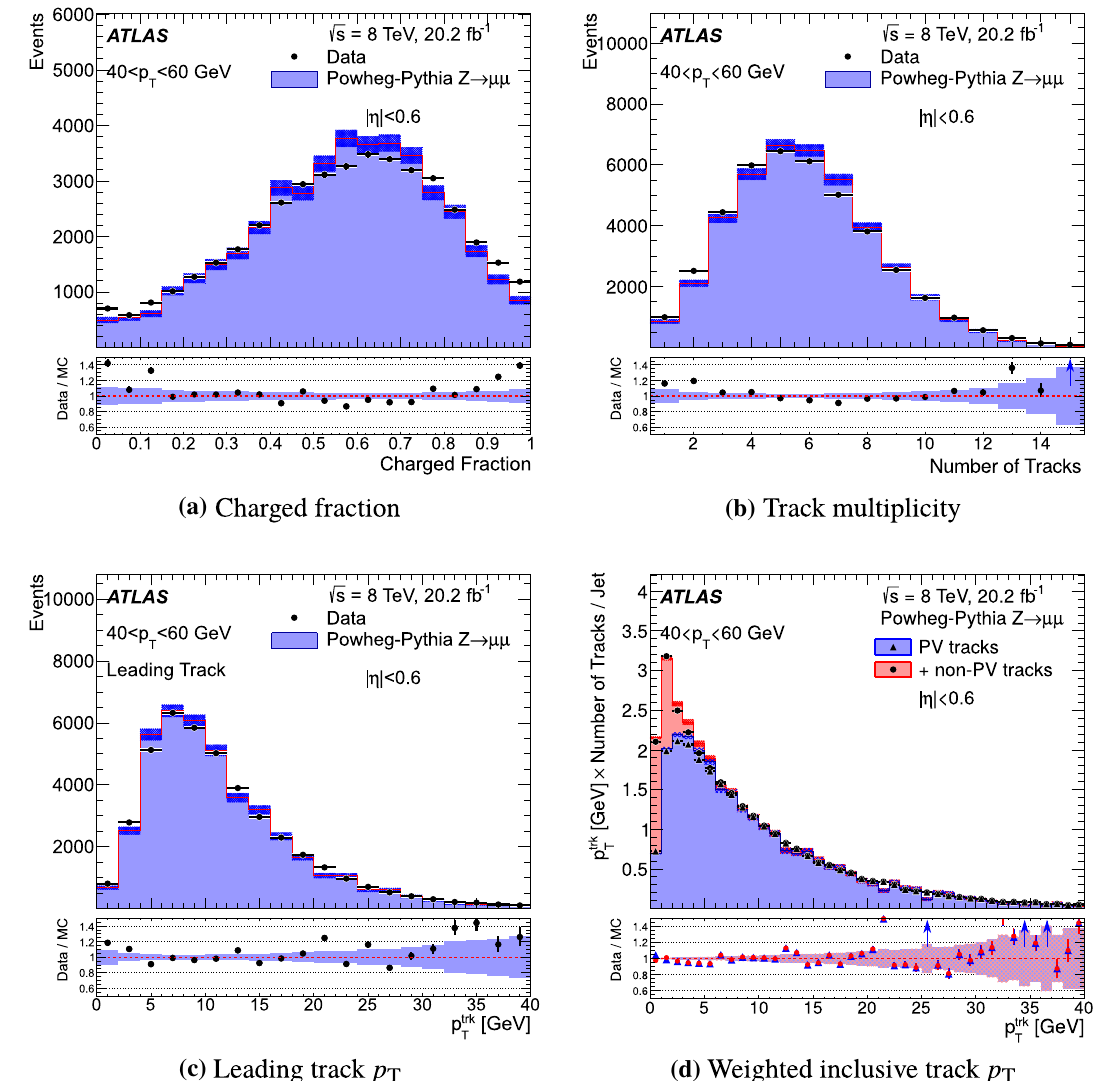
Fig. 34 Comparison of jet track properties, for a selection of jets with 40 < p T < 60GeV and | η | < 0 . 6, selected in Z → μμ events from collision data and MC simulation. The simulated samples are nor- malised to the number of events in data. The following distributions are shown: a the charged fraction, i.e. the fractional jet p T carried by recon- structed tracks; b the number of tracks in the jet that originate from the nominal hard-scatter primary vertex; c the transverse momentum of the leading track in the jet; d the transverse momenta of all tracks in the jet